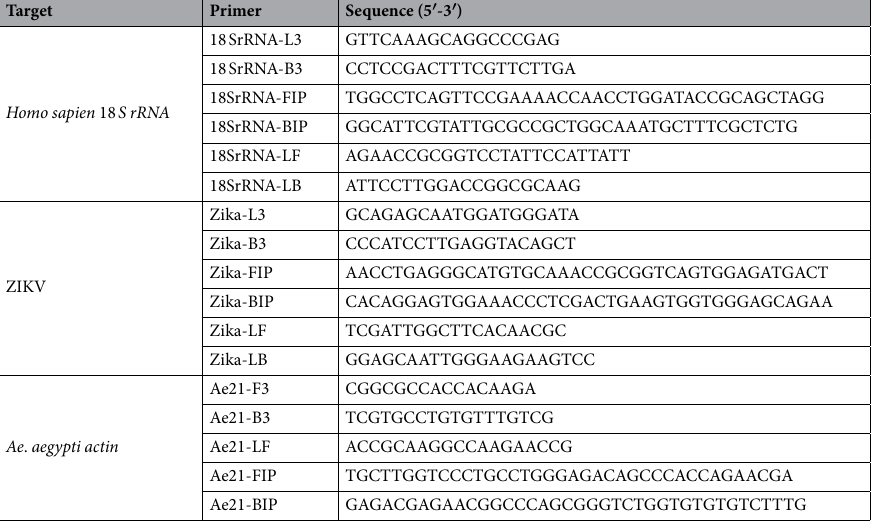
Table 2. RT-LAMP Primer Sequences used to detect ZIKV, human 18 s rRNA, and Ae . aegypti actin